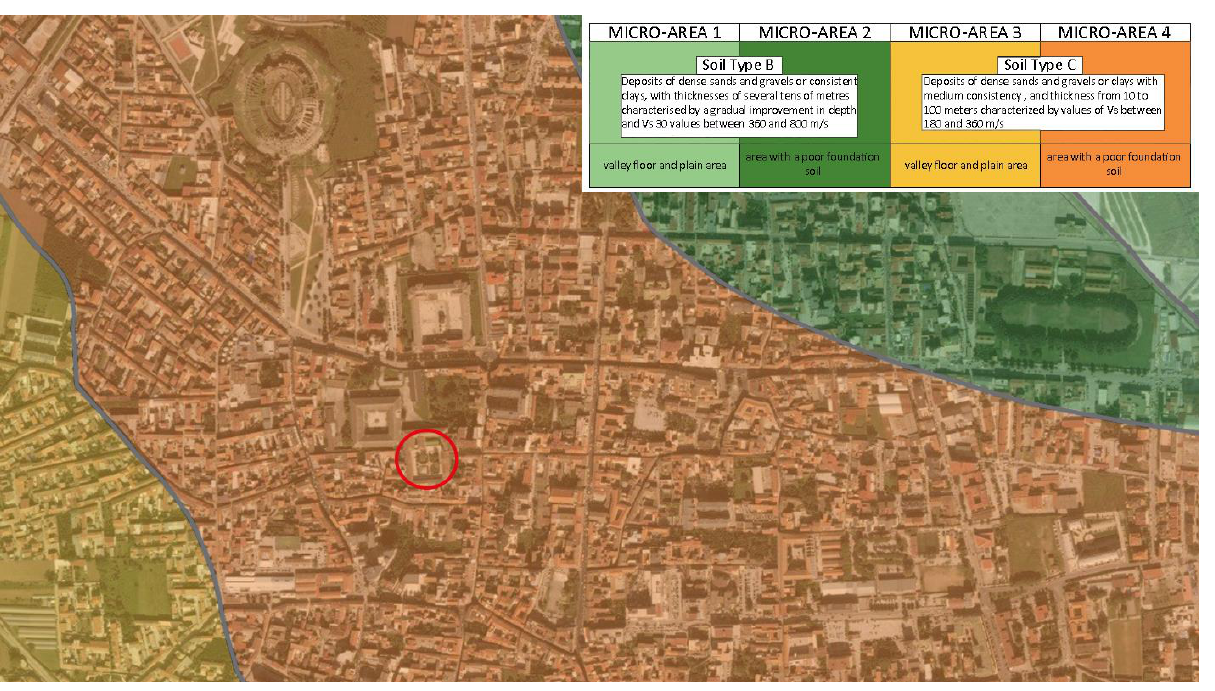
Figure 5. Map of homogeneous areas zoning in seismic perspective: the red circle identifies the location of the Archaeological Museum of the Ancient Capua.